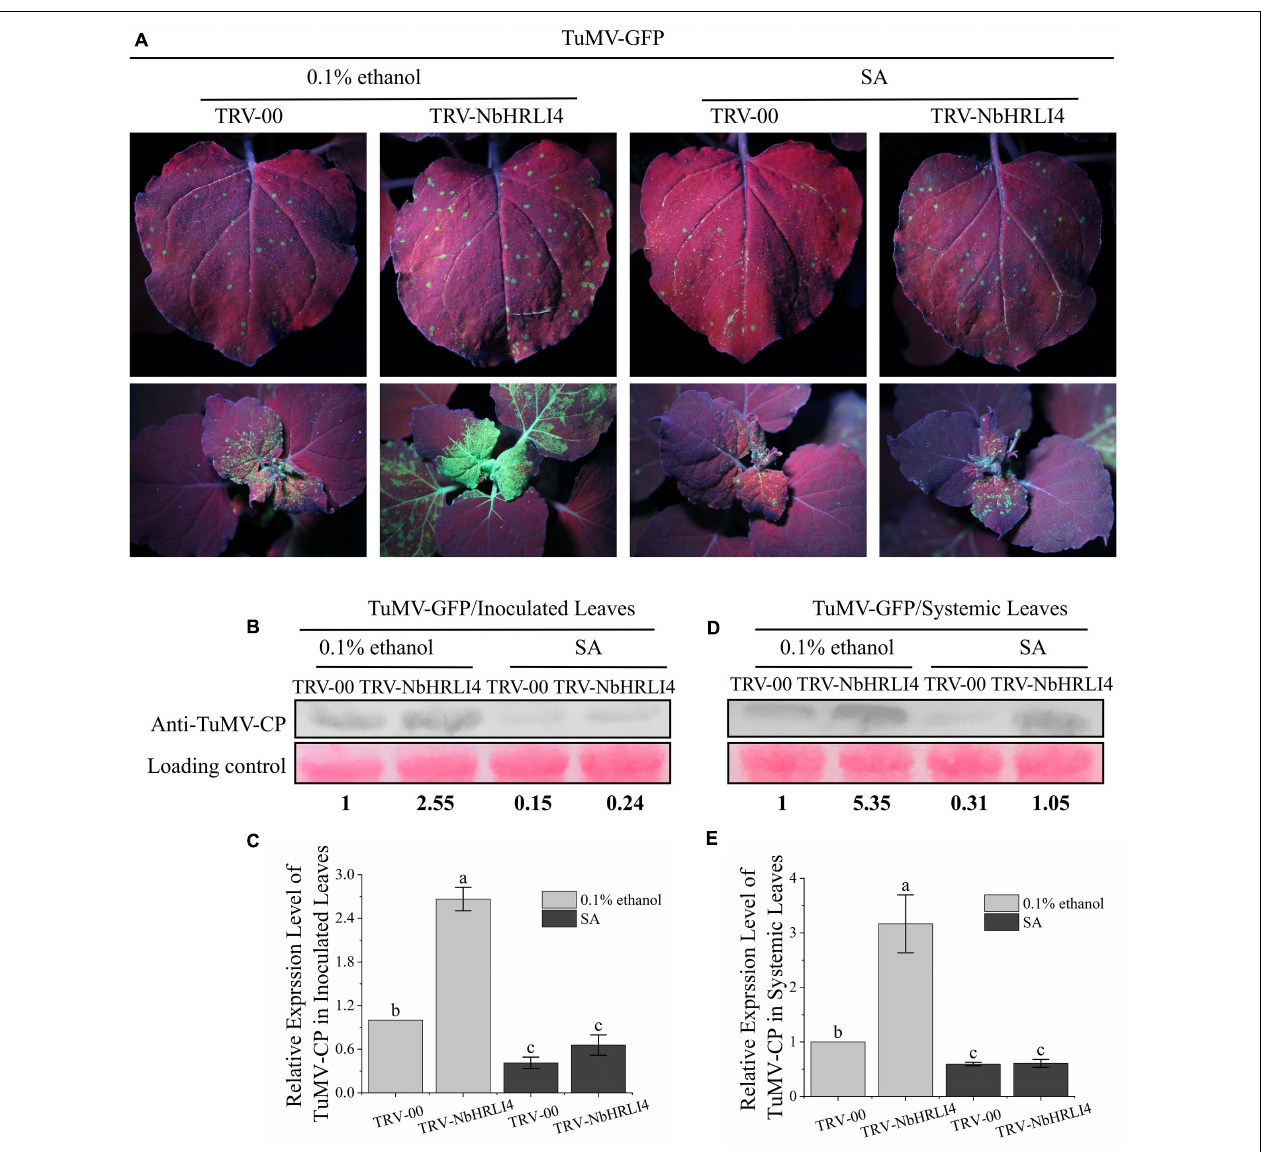
FIGURE 6 | SA is required in NbHRLI4-mediated resistance against TuMV. (A) Inoculated and systemic leaves after SA application to plants inoculated with TRV-HRLI4 or TRV-00 (WT) and TuMV-GFP, observed under UV light at 4 dpi. (B,C) Western blotting and RT-qPCR detection of TuMV-CP (B) and mRNA (C) in the inoculated leaves of plants inoculated with TRV-HRLI4 or TRV-00 (WT) and TuMV-GFP and treated with SA or 0.1% ethanol (control). (D,E) As panels (B) and (C) but for the systemic leaves. The mean expression values in this figure were analyzed using F -test. Different letters on histograms indicate significant differences ( P <